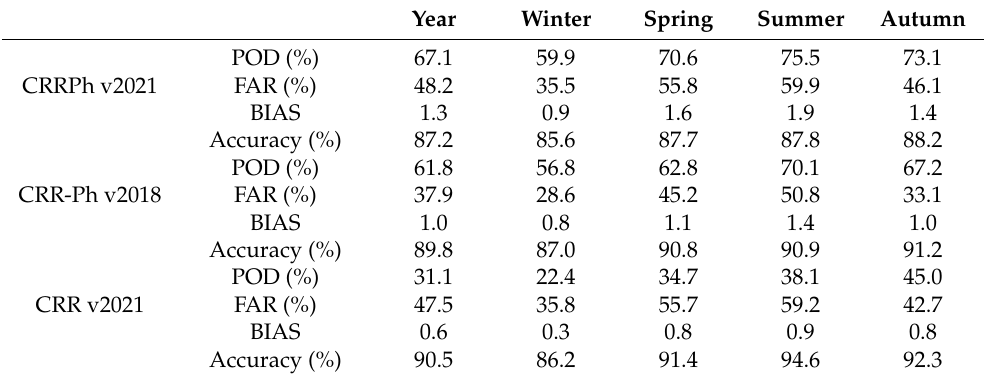
Table 3. Daytime categorical statistics for CRRPh v2021, CRR-Ph v2018, and CRR v2021.